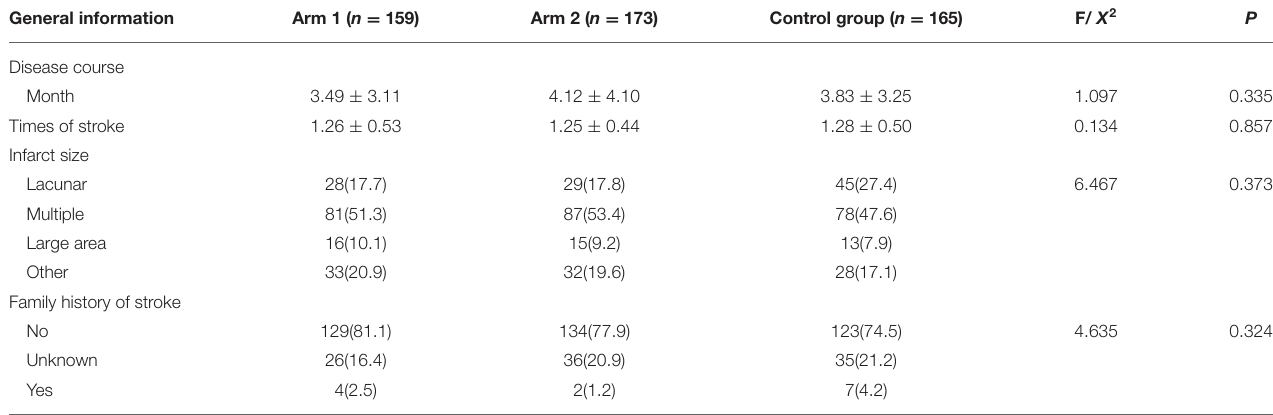
TABLE 2 | Ischemic stroke